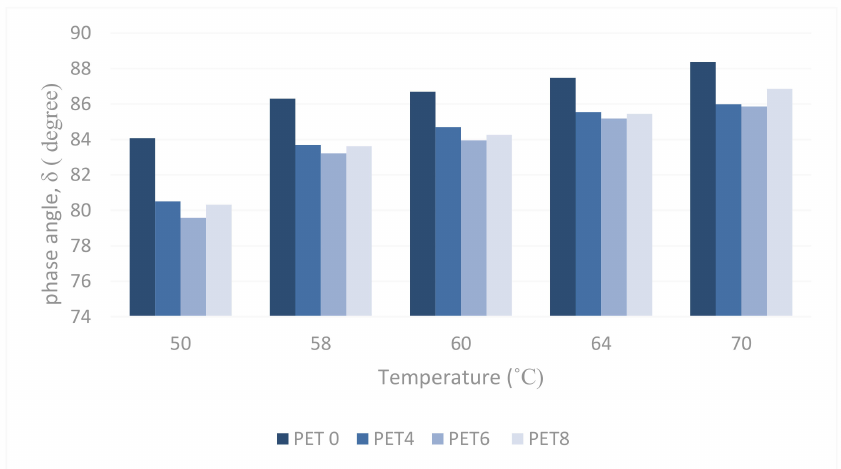
Figure 5. Phase angle results of PET-modified binders after